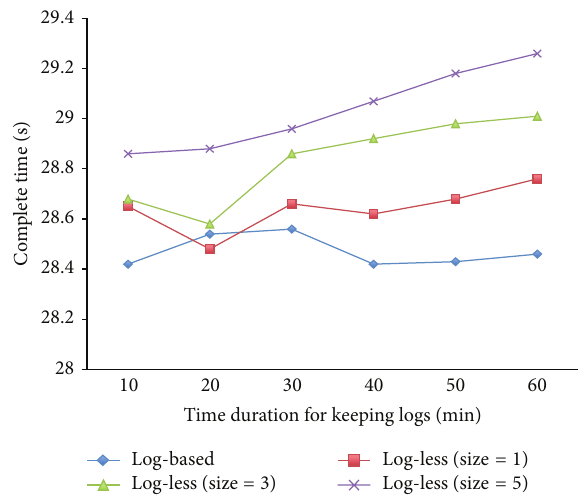
Figure 4: The overhead of backing up requests on client